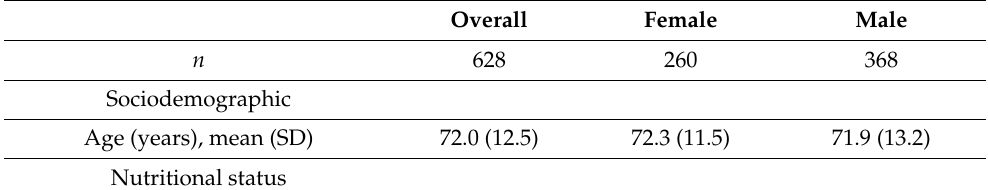
Table 1. Baseline characteristics of malnourished cancer